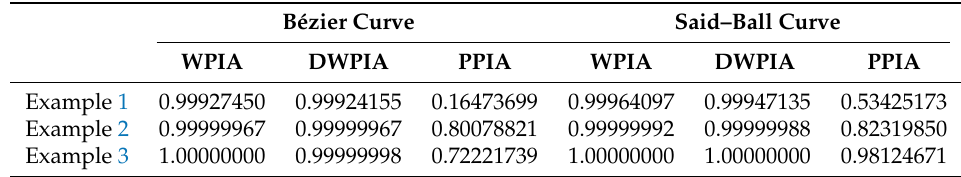
Table 2. The approximation errors and runtimes of WPIA, DWPIA and PPIA in Example 1. Curve k